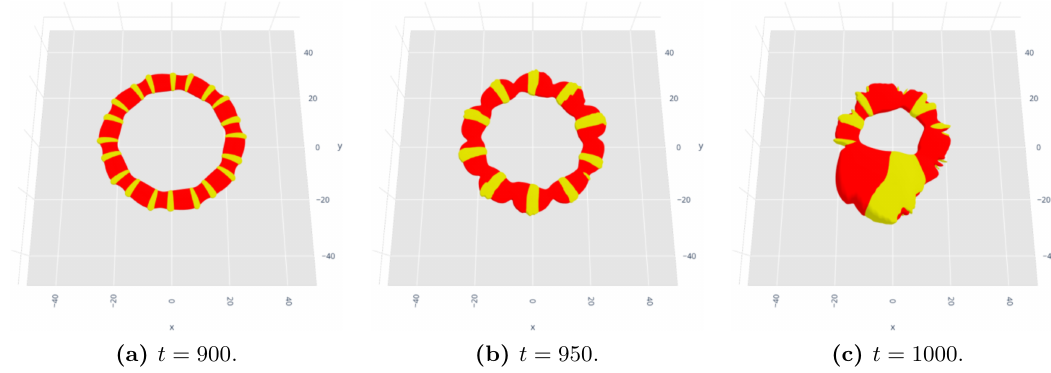
Figure 22 . Isosurfaces of a vorton with Q = 637 . 7 and N = 20 in the parameter set η φ = 1 , η σ = 0 . 61 , λ φ = 1 , λ σ = 10 , β = 3 and G = 0 . 5 (parameter set B). | φ | = 3 η φ is shown in red and 5 Re ( σ ) = 1 η σ is shown in yellow. We have excited all of the modes between m = 2 and m = 30 with 5 an amplitude of 0.001. At t ∼ 950 the pinching instability to the m = 10 mode becomes clear. There may be instabilities due to additional modes which will not appear because the rate of growth is smaller. The vorton is ultimately destroyed by the pinching instability — with a ten-fold symmetry — developing into a bubble of the true vacuum, as seen in figure 22c, which quickly expands. Note that it is visually very different to the vorton destruction mechanism seen later in figure